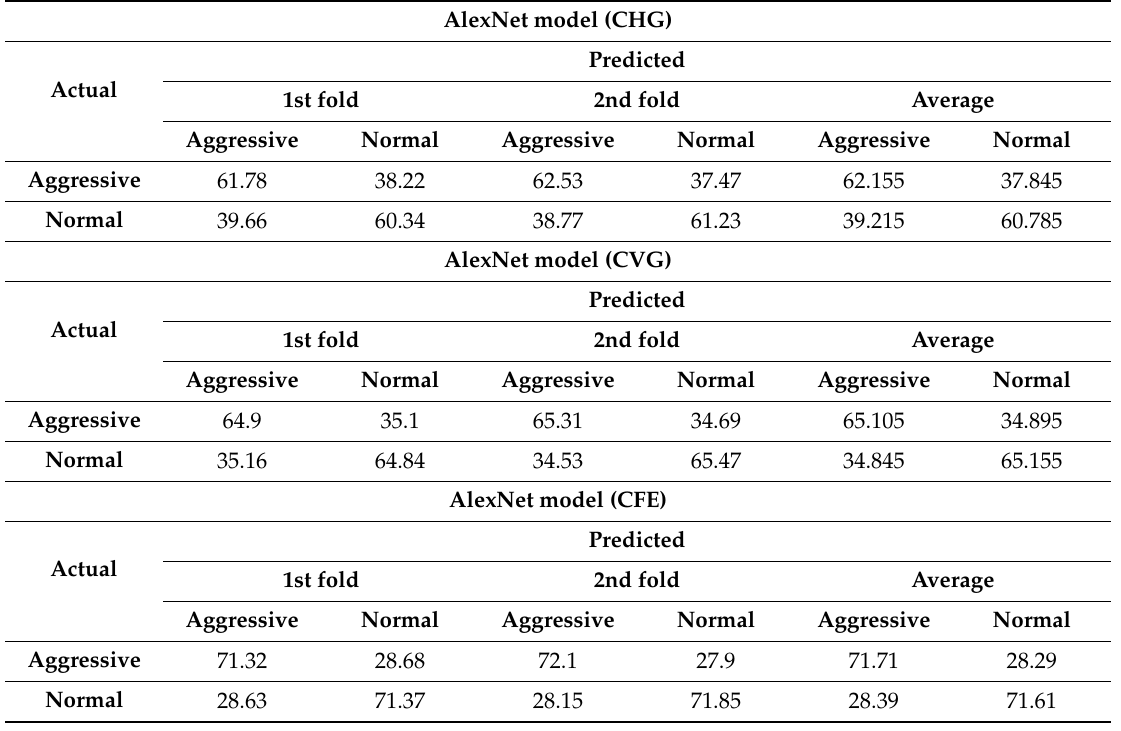
Table 10. Classification accuracies by AlexNet model